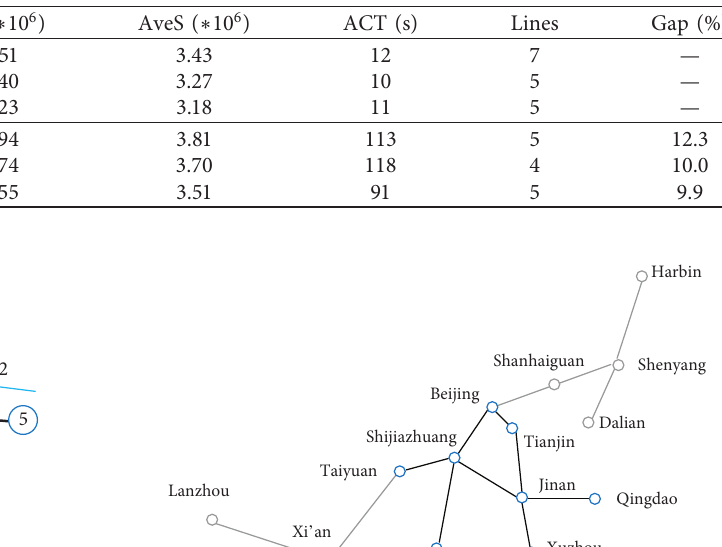
Table 5: Comparison between AIA and MHIA on small HSR network.